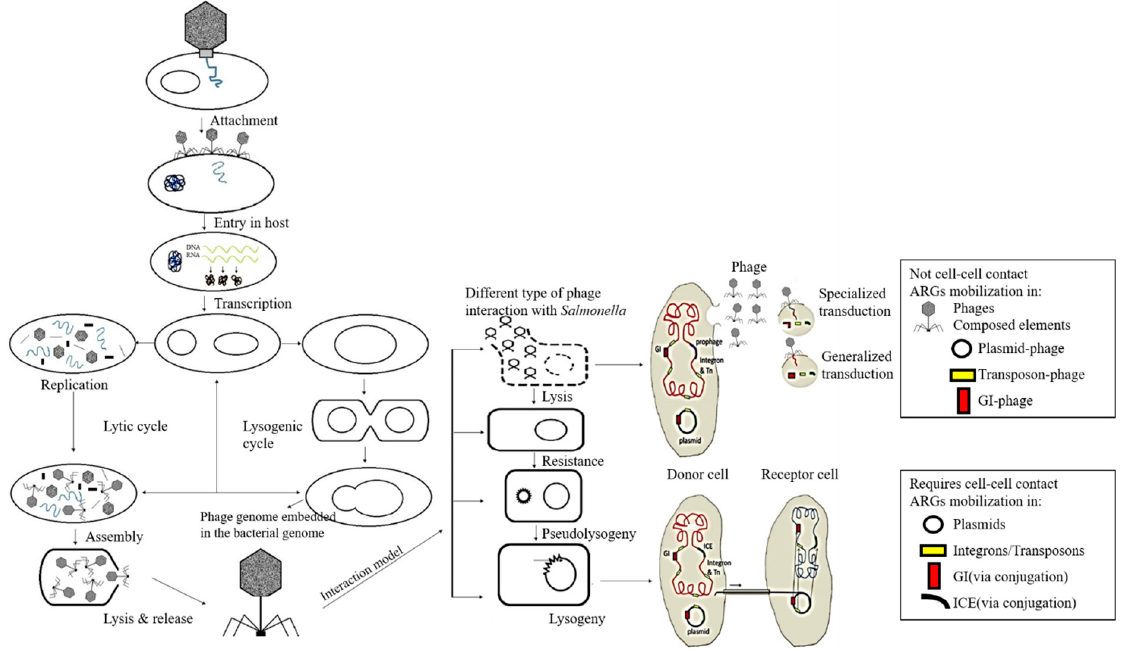
Figure 2. Life cycles of bacteriophages. (Copyright obtained from Kakasis et al., 2019; de Jonge et al., 2019, [57,58].)